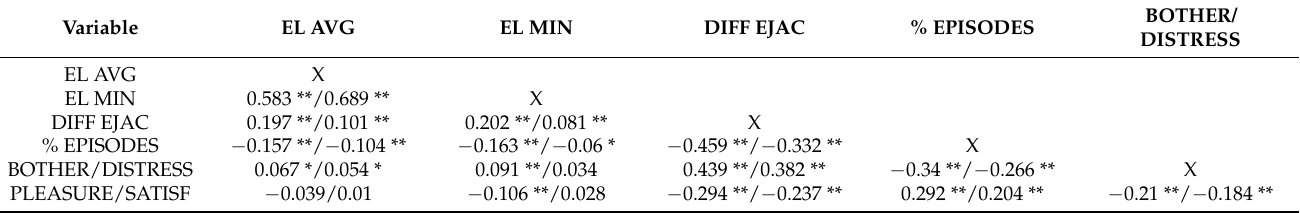
Table 3. Spearman correlations among proposed face-valid measures for DE diagnostic criteria. Left- hand correlation in each cell represents partnered sex; right-hand correlation represents